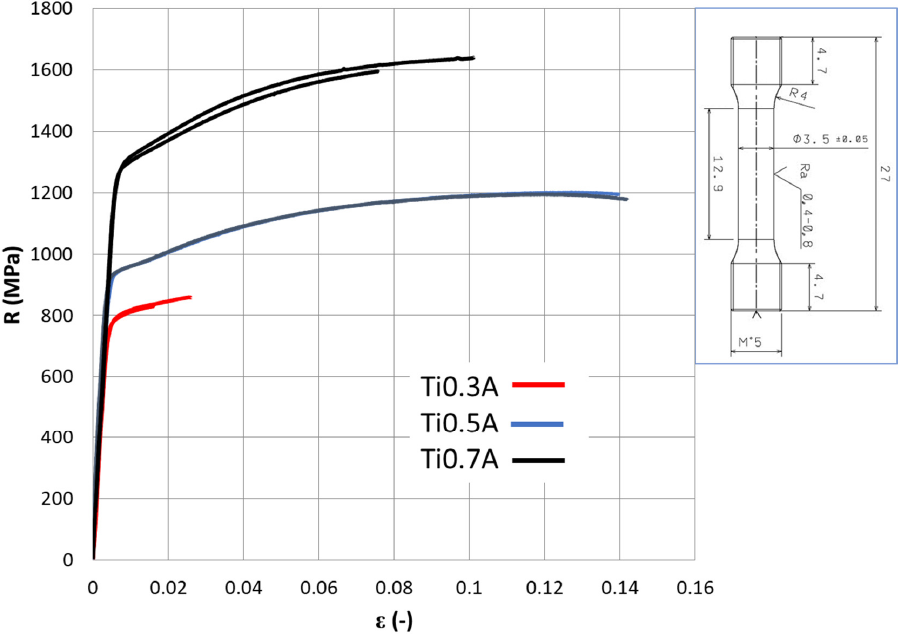
Figure 6. The tensile curves obtained from the Ni 1.5 Co 1.5 CrFeTi X alloy specimens after annealing. The sample geometry is presented on the right-hand side, dimensions in sample geometry is presented on the right-hand side, dimensions in mm.